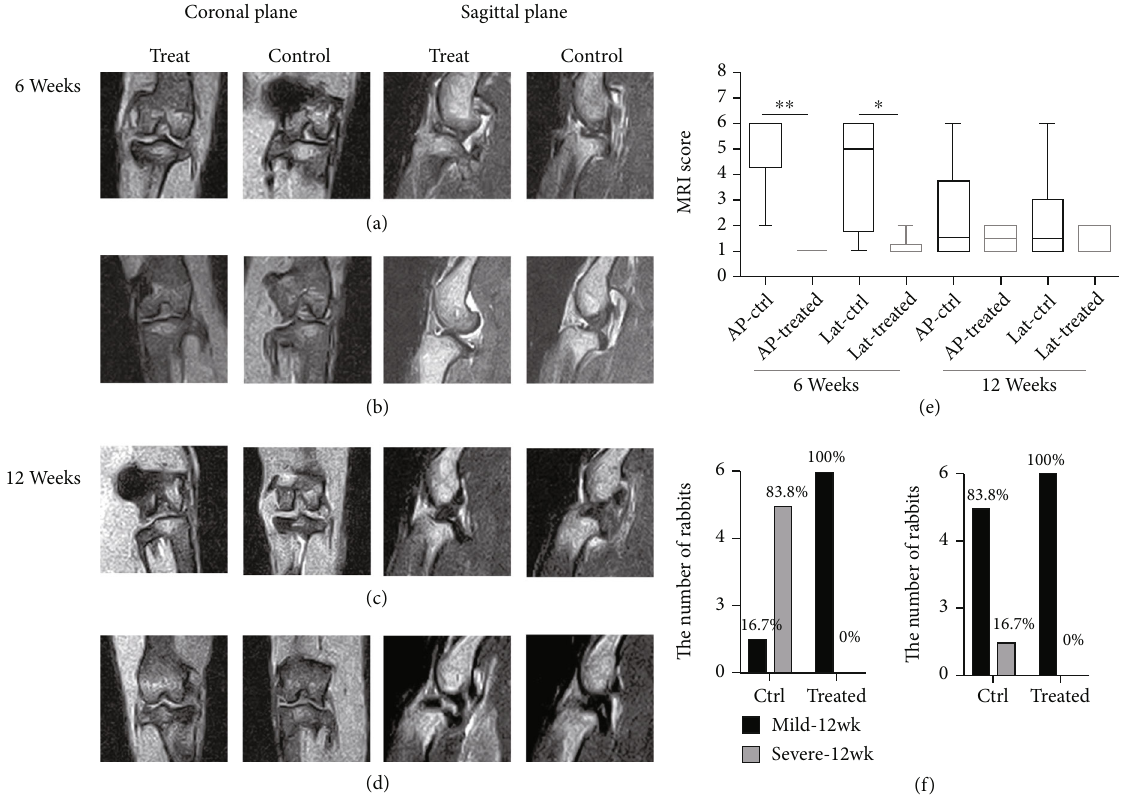
Figure 4: Knee joint MRI studies (HUCMSC 1 × 10 7 cells+HA and normal saline control) at 6 weeks and 12 weeks ( n = 6 ). (a) and (c) are taken from the same rabbit while (b) and (d) are from another. (e) The joints receiving 1 × 10 7 HUCMSC+HA therapy show a signi fi cant decrease of the severity of osteoarthritis at 6 weeks than normal saline control knees, but they show no signi fi cant reduction of the severity of osteoarthritis at 12 weeks. AP: anterior-posterior view; Lat: lateral view; Ctrl: control. (f) The comparison of the number of rabbits and percentage of rabbits with mild and severe joint destruction diagnosed by MRI examination between normal saline control and treatment groups. Left panel and right panel revealed the lesion observed at 6 and 12 weeks after treatment, respectively. The p value in 6 and 12 weeks between the two groups is 0.008 and 0.5, respectively.